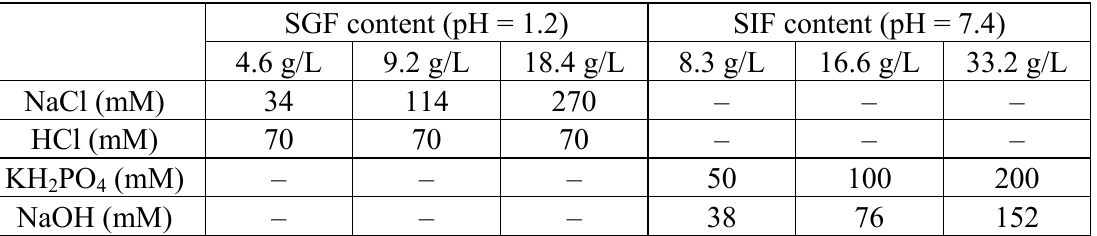
Table 5. Composition of SGF and SIF